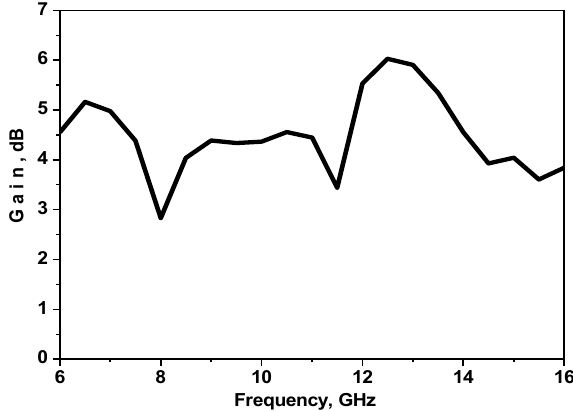
Fig.11. The gain of the antenna at a different frequency.